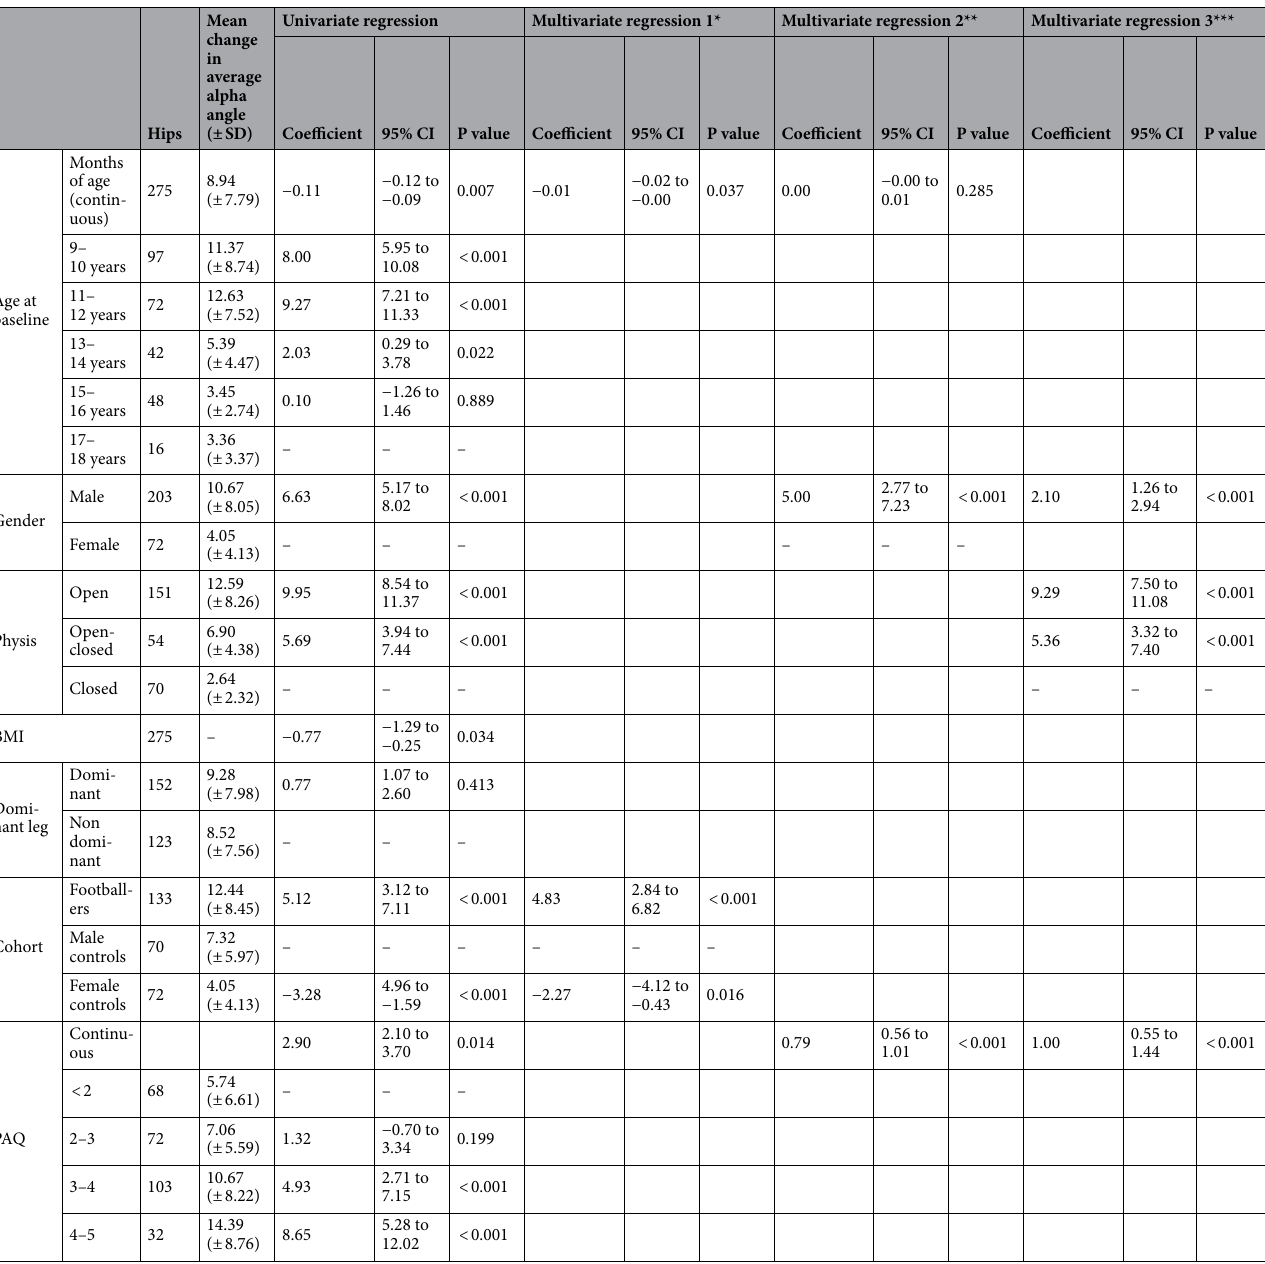
Table 2. Predictors of change in average alpha angle. *Age and cohort as covariables. **Age, gender, and Physical Activity Questionnaire as covariables. ***Physeal maturity, gender, and Physical Activity Questionnaire as